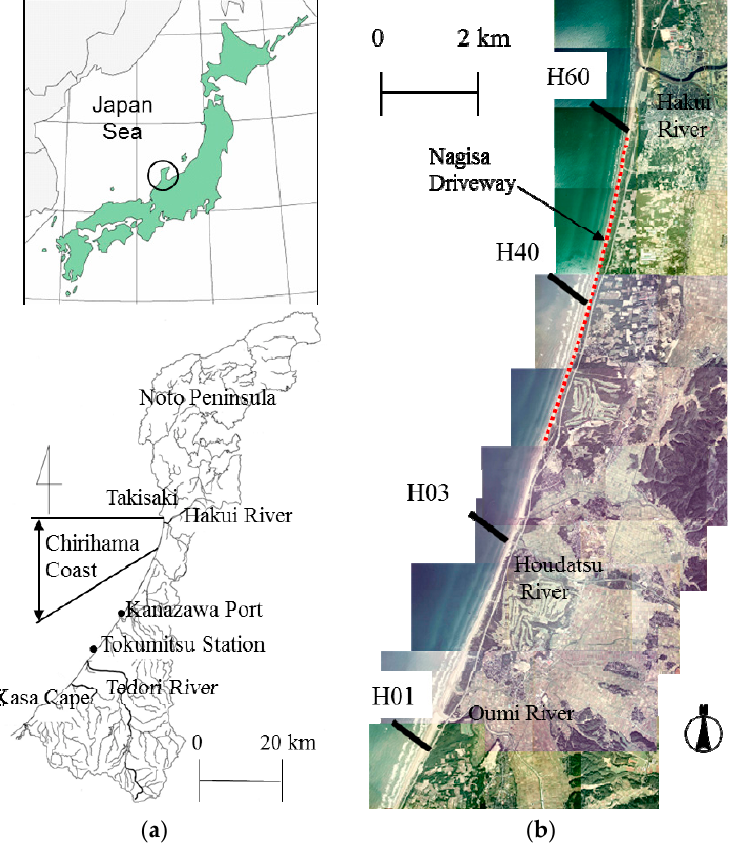
Figure 1. Field site: ( a ) location of the study site; ( b ) location of the cross ‐ shore survey lines (H stands for the Hakui district where the Chirihama Coast is located.).